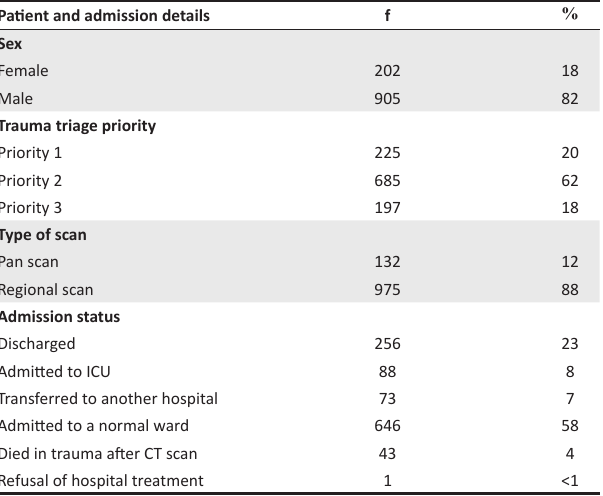
TABLE 2: Patient